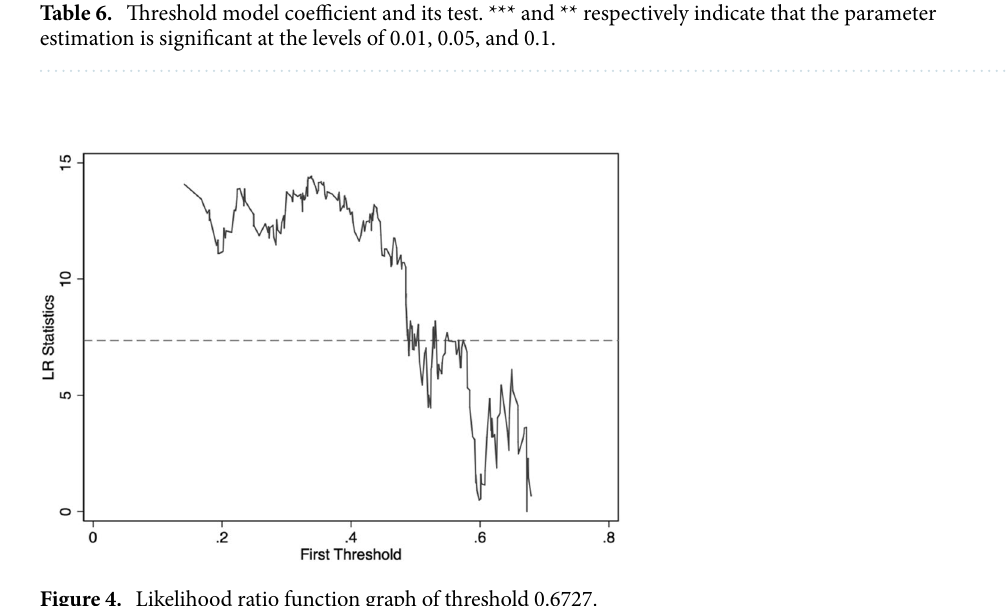
Figure 4. Likelihood ratio function graph of threshold